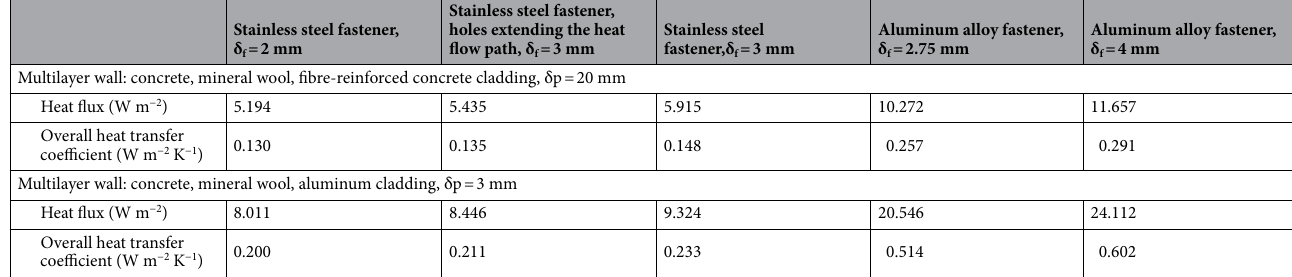
Table 5. The results of the simulation calculations, including the heat flux penetrating 1 (m 2 ) of the wall and the heat transfer coefficients for individual variants of the multilayer wall.